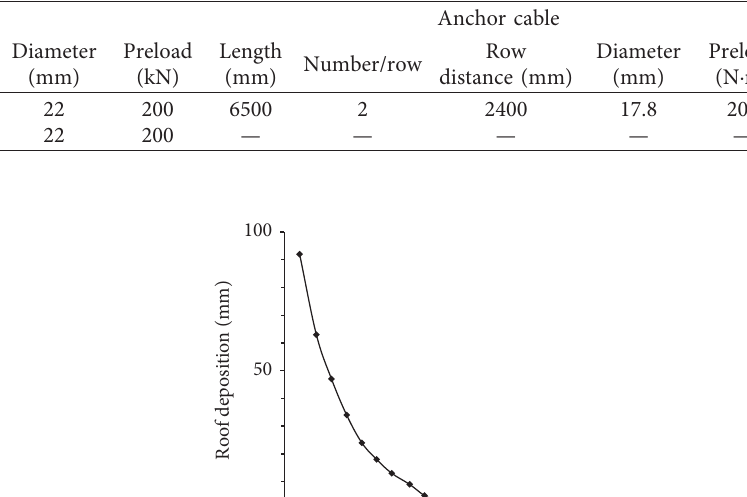
Table 2: Rock bolt support parameters of 1905S